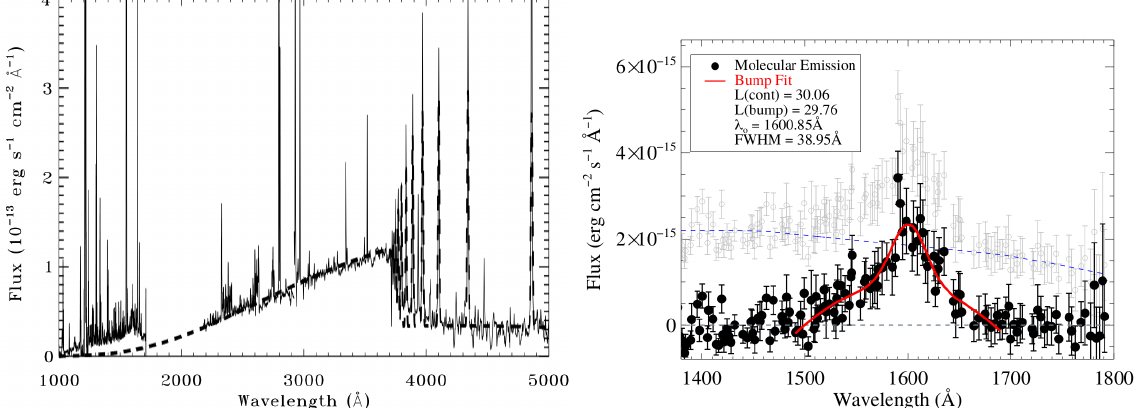
Figure 8. Left : FUV to optical spectrum of the nearest CTTS, TW Hya, after subtraction of the WTTS template spectrum of V819 Tau. The dashed line indicates the expected emission from the accretion model, which approximates the NUV continuum of TW Hya but significantly underestimates the FUV continuum, especially around 1600Å. From Herczeg et al. [80]. Right : Typical 1600Å-Bump spectrum, here for CS Cha. The blue-dashed line indicates the polynomial model used to subtract the accretion continuum. From France et al. [36]. Both figures: c AAS. Reproduced with permission. (cid:13) France et al. [36] detect the 1600 Å-Bump in 19 out of the 37 CTTSs surveyed. The detection rate is 100% in transition disks, compared to about one third in primordial or non-transition disk sources. Because the integrated flux of the 1600 Å-Bump is a significant fraction of the entire H 2 and continuum